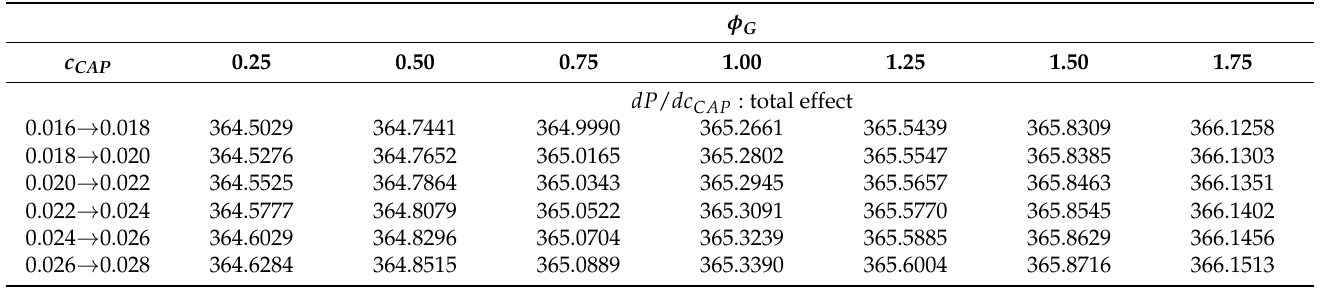
Table 5. Responsiveness of policyholder protection to c CAP at various gray rhino levels. φ